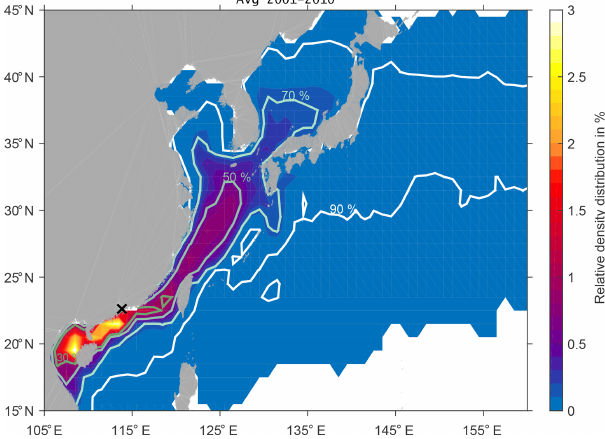
Figure 3. Annual mean surface (20m) spread of DBPs from dis- charge in Singapore relative to the total number of particles re- leased. Contours show the area of the percentage of particles (30%, 50%, 70% and 90%) characterised by the highest